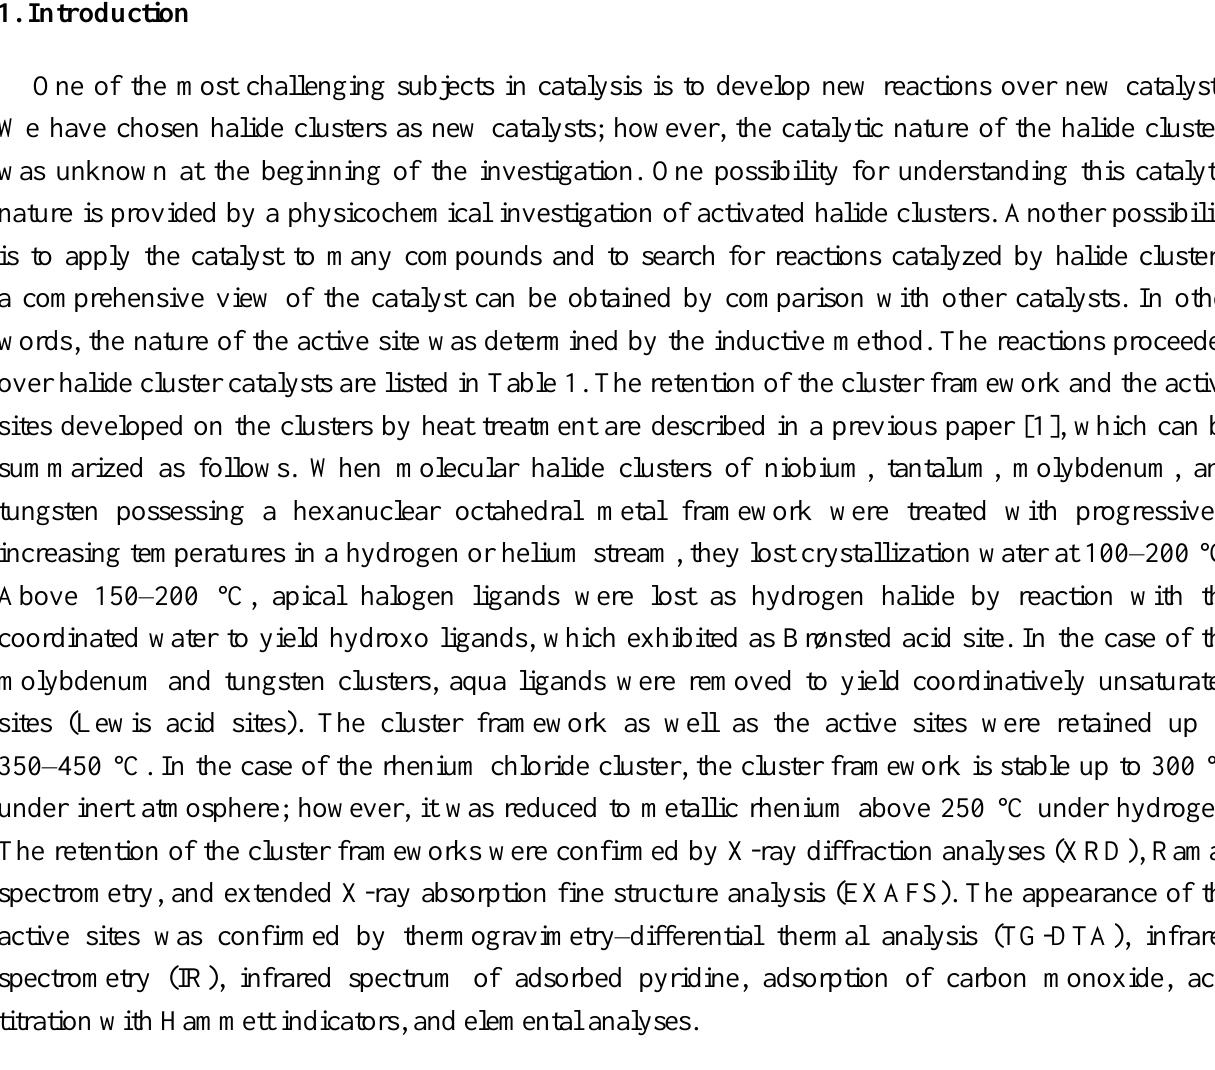
Table 1. Reactions catalyzed by halide